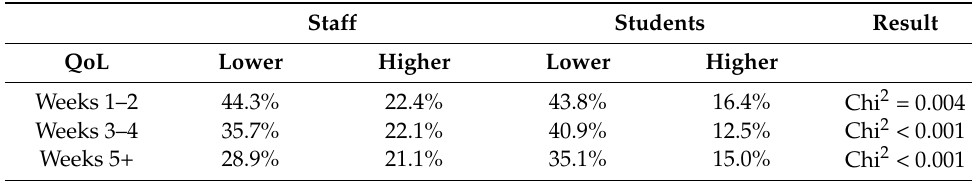
Table 2. Quality of Life (QoL).